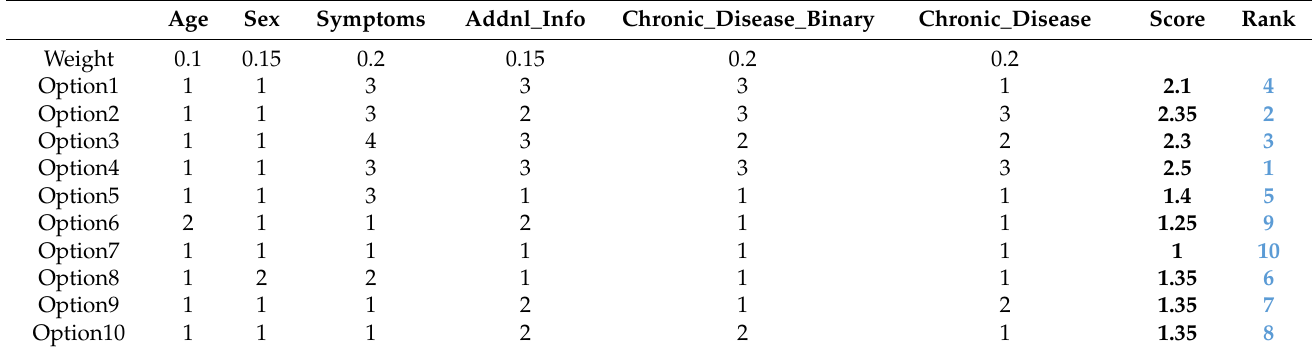
Table 4. Weighted scoring table.